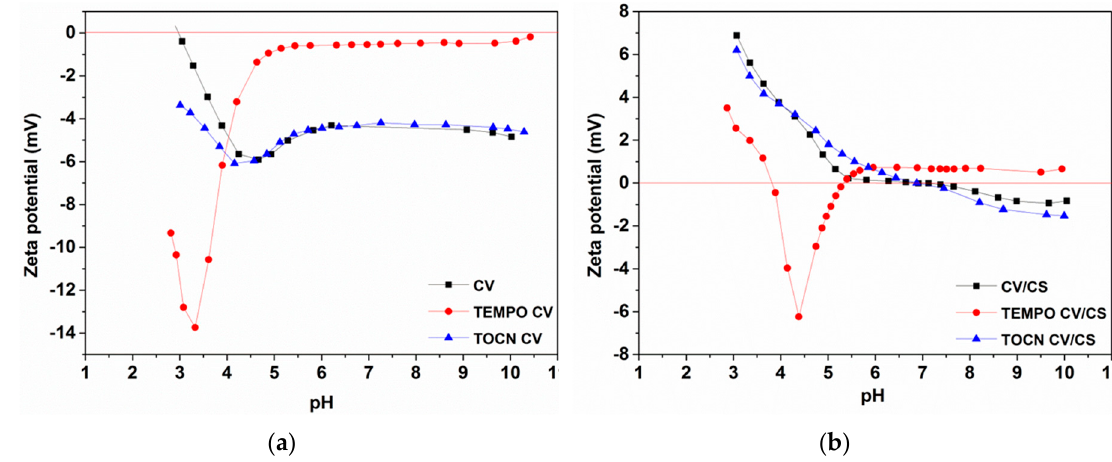
Figure 2. Zeta potential of pristine and pretreated viscose fabric ( a ) before and ( b ) after chitosan